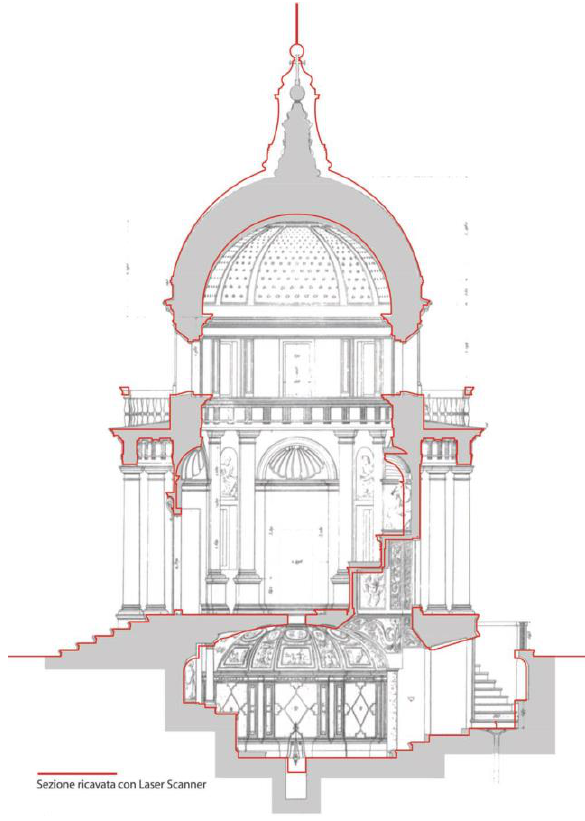
Figure 2. Comparison between Letarouilly’s drawing and a recent laser scanner survey (Fortunato,